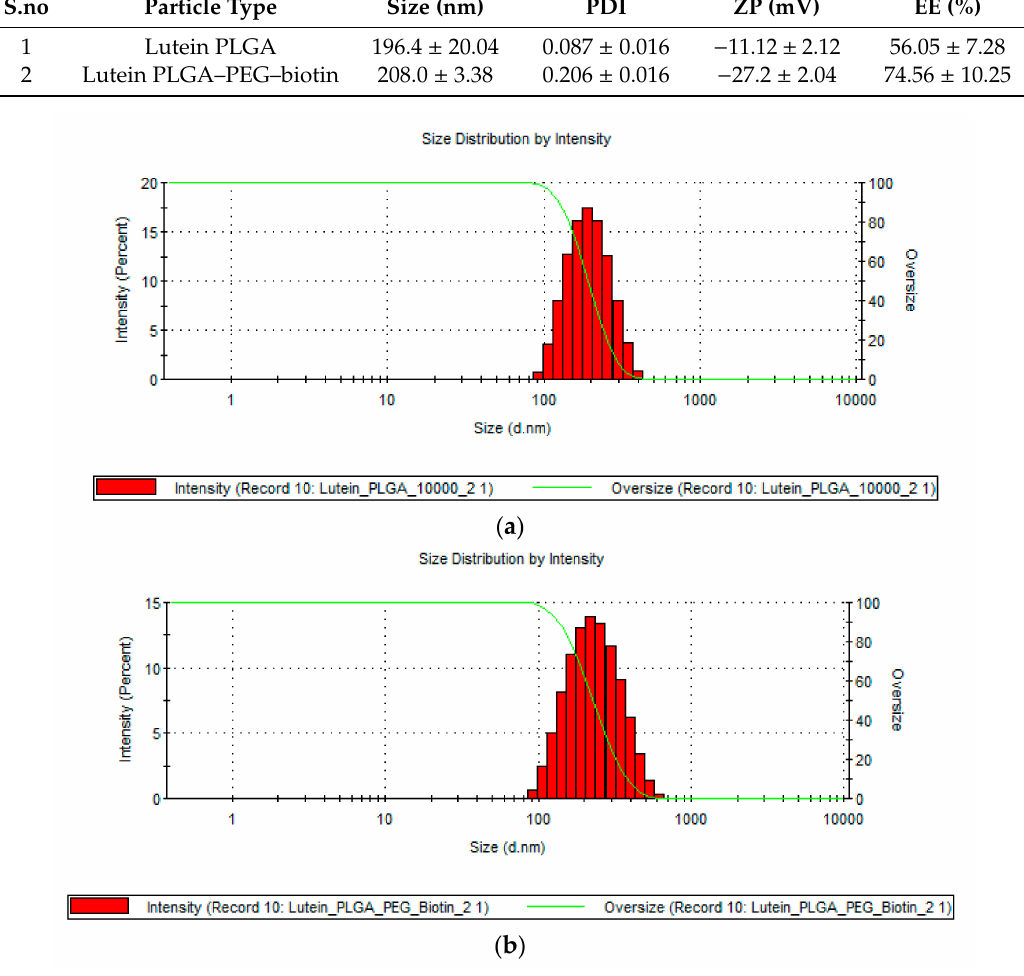
Figure 2. Size distribution curves of ( a ) lutein–PLGA nanoparticles and ( b ) lutein PLGA–PEG– biotin